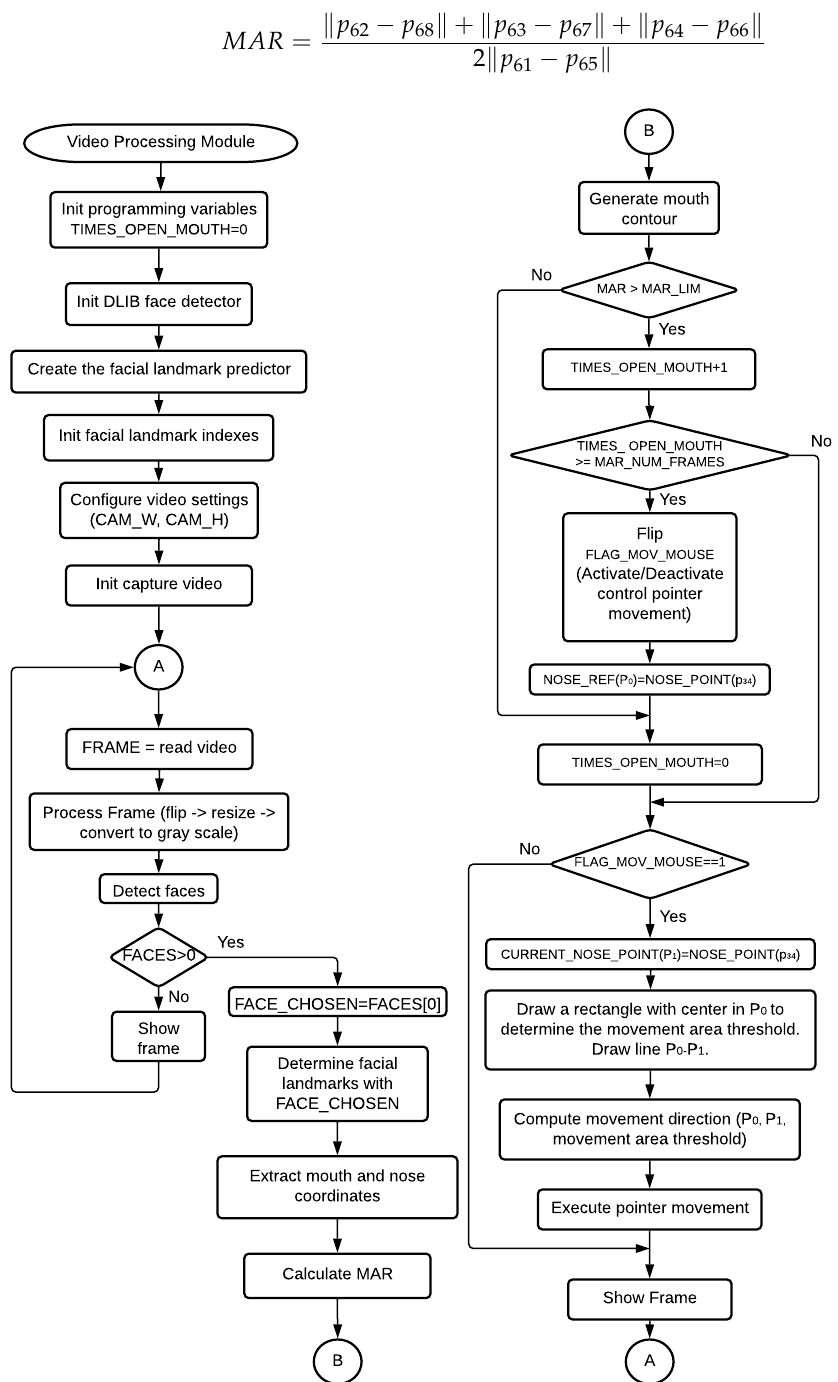
Figure 3. General flowchart of the video processing module. Note: The programming constants are: CAM_W = 640, CAM_H = 480, MAR_LIM = 0.6, MAR_NUM_FRAMES =